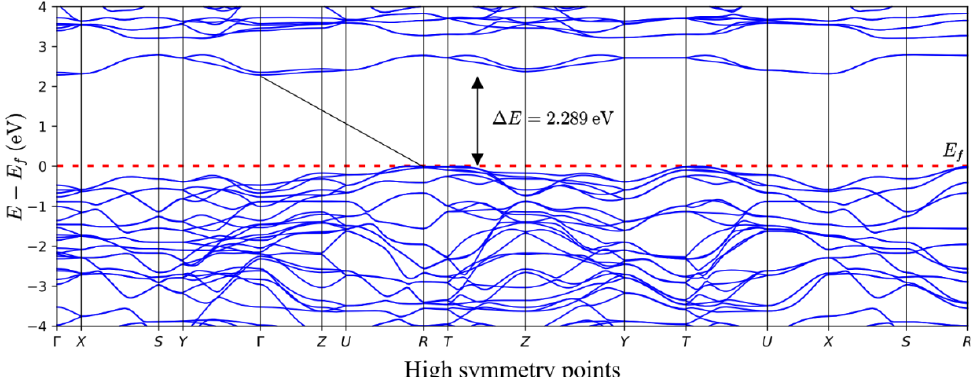
Figure 7. Band structure of V 2 O 5. The red dotted line denotes the Fermi level. The black line connects the top of the valence and the bottom of the conduction zones.